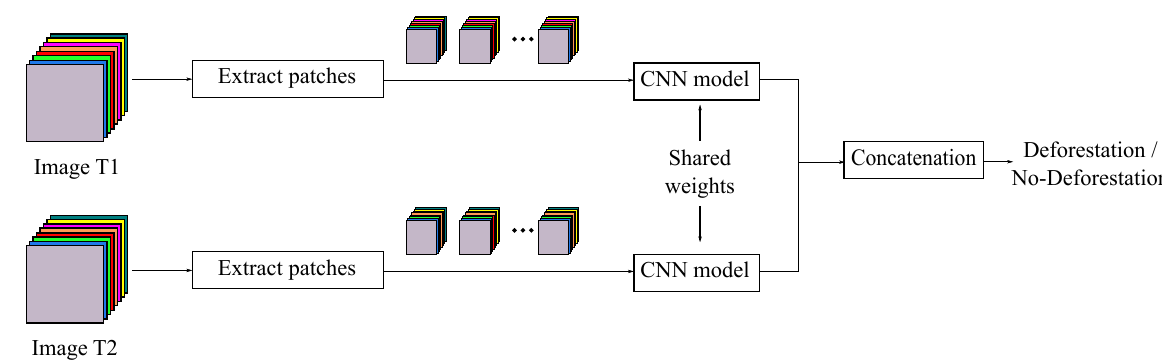
Figure 1. EF approach. Images at different dates (T1 and T2) are concatenated to produce an image pair; then, patches are extracted and fed to the CNN model.